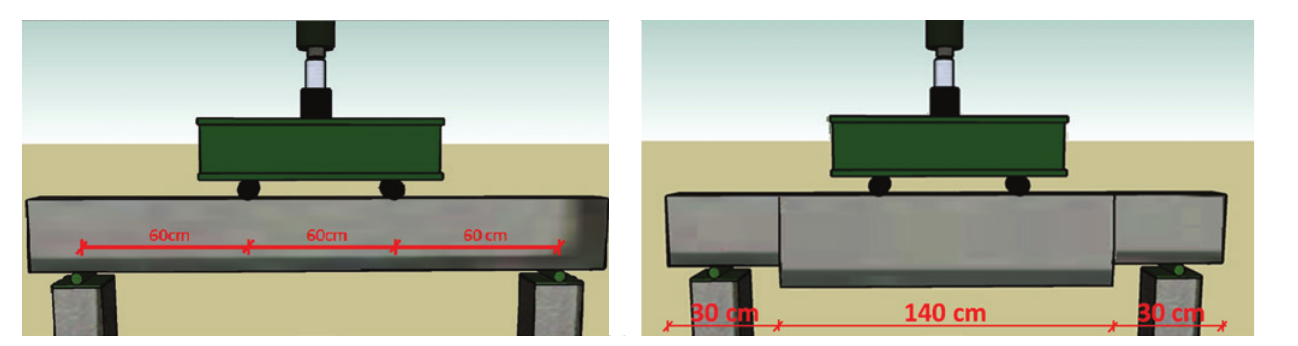
a) Beams without reinforcement b) Reinforced beams Test pattern of the beams